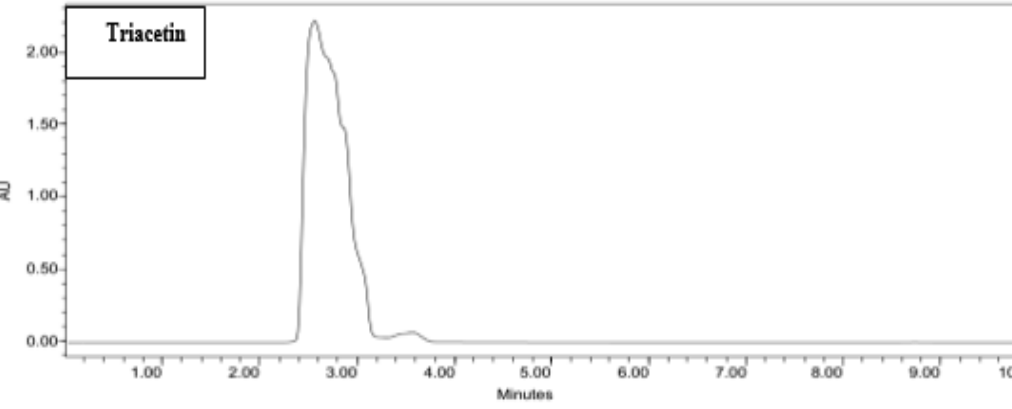
Continue figure 13. Chromatograms of pure Lacidipine and triacetin, respectively.